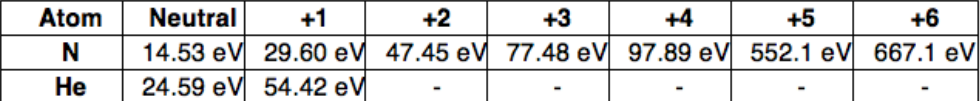
Figure 12. Ionisation potentials of N and He. The second row gives the ionisation energy of N from neutral N to hydrogen-like N. The third row reports the corresponding ionisation energies for neutral He and hydrogen-like